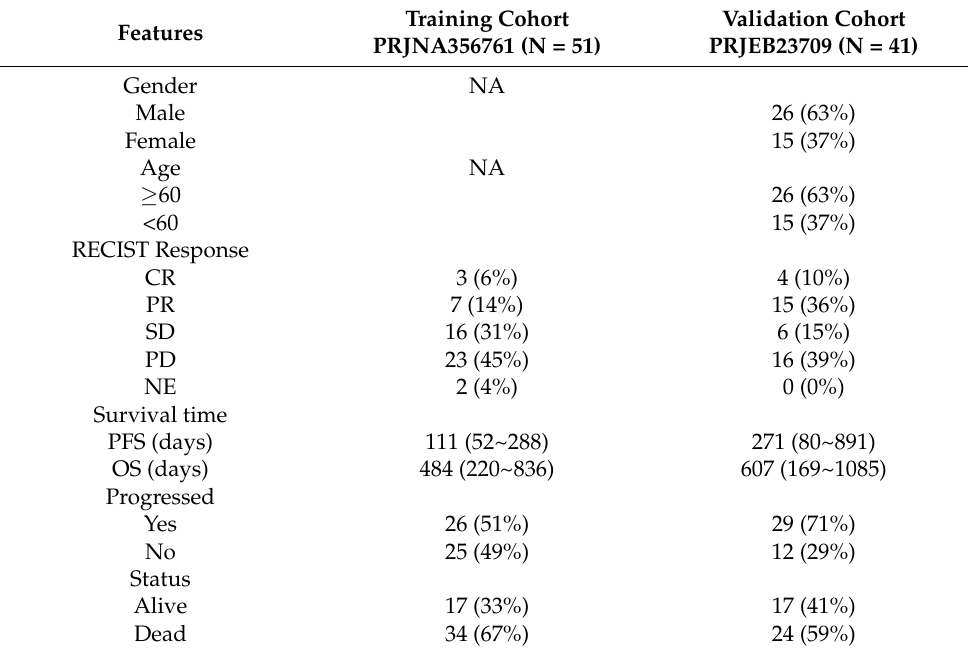
Table 1. Characteristics of patients in the training and validation cohorts.